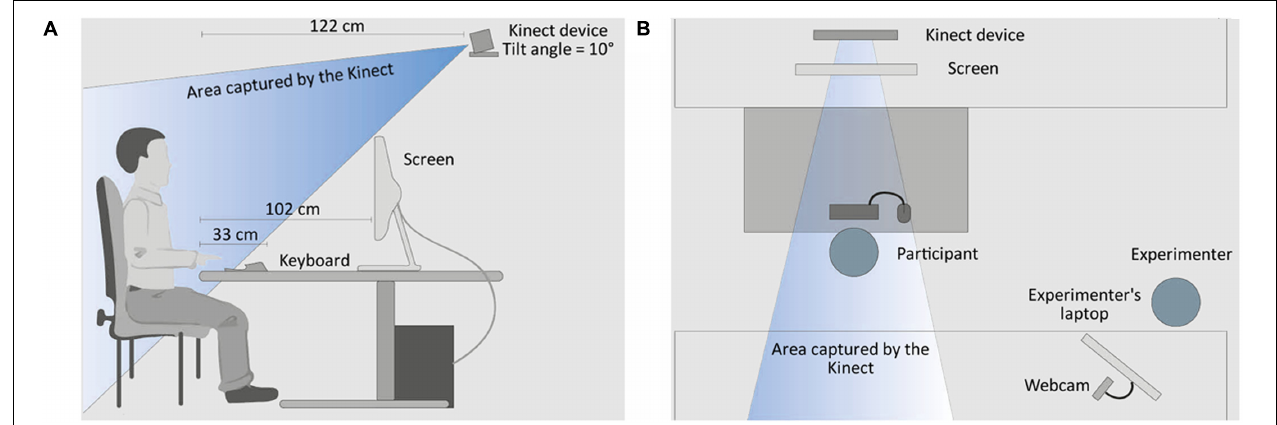
FIGURE 3 | Experimental setup: (A) profile view showing the position of the participants in relation to the gaming screen and the Kinect device; (B) top view showing the position of the participants in relation to the experimenter.